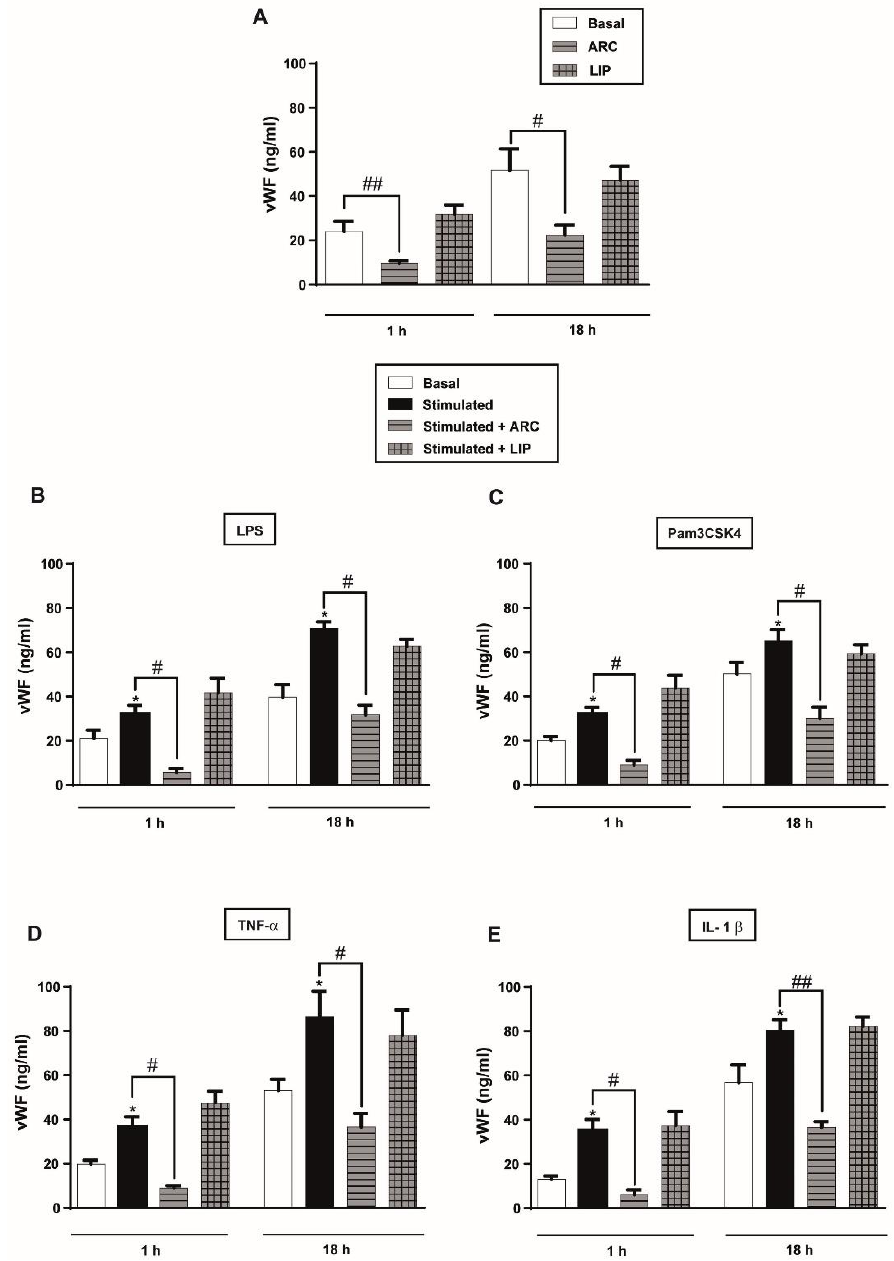
Figure 5. ARC decreases the amount of vWF released by endothelial cells. HUVEC were ( A ) unstimulated or stimulated with ( B ) LPS (1 µ g/mL); ( C ) Pam3CSK4 (1 µ g/mL); ( D ) TNF- α (3 ng/mL) or ( E ) IL-1 β (1 ng/mL) and incubated with nanoarchaeosomes (ARC) or liposomes (LIP) at a concentration of 50 µ g/mL for 1 and 18 h. The vWF concentrations in the supernatants were determined by ELISA (one-way ANOVA followed by Bonferroni multiple comparisons test; * p < 0.05 vs. basal; # p < 0.05 and ## p < 0.01 between the labeled groups). Results are the mean ± SEM of four to five independent experiments.